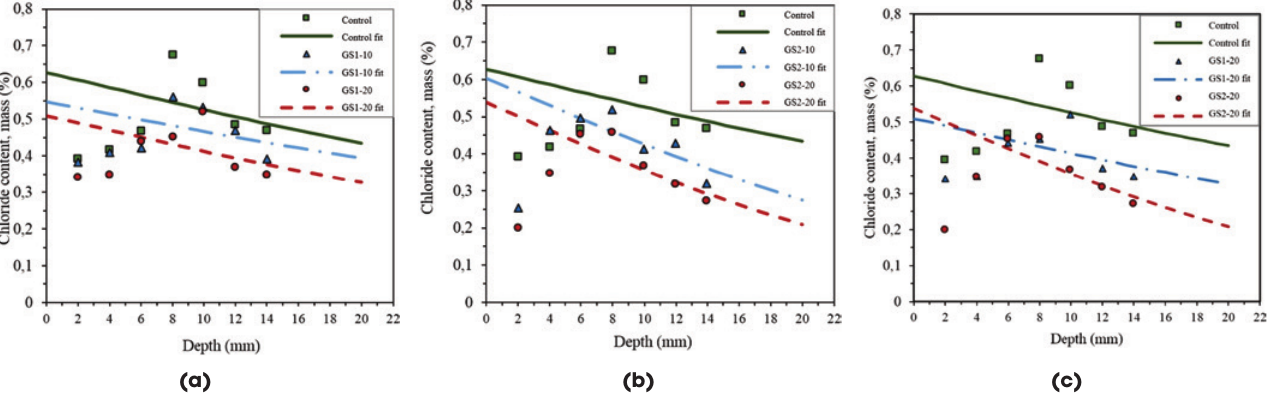
Linear regression analysis of chloride content through concrete depths. (a) Glass sludge waste without